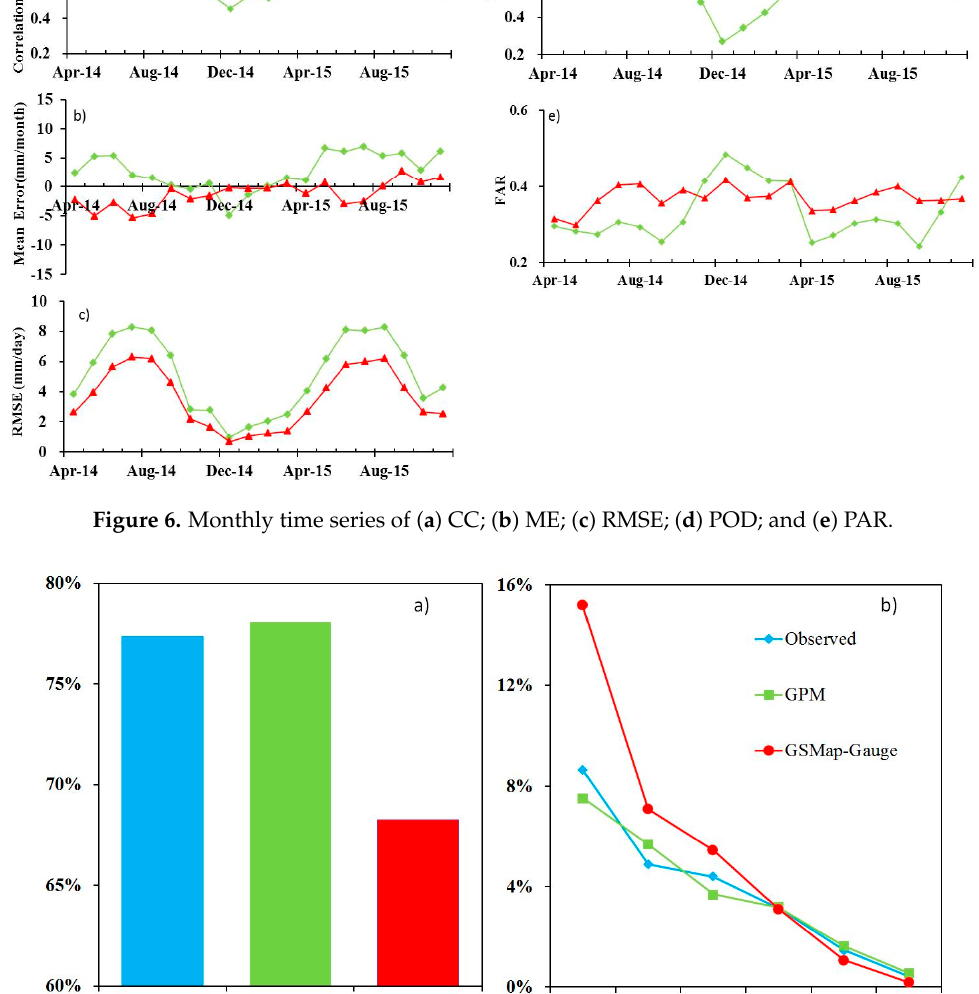
( ≤ 1 mm/day) case; ( b ) The frequency distribution of daily precipitation by occurrence for the different intensities. Only grids containing at least one gauge station and for which both the reference and the satellite estimates were not missing were selected for calculation.